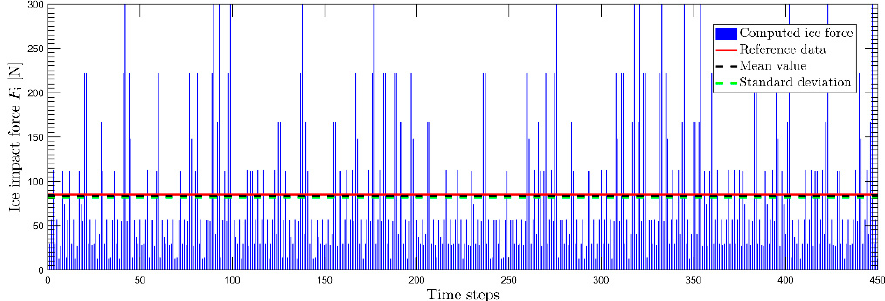
Figure 14. Result comparison for V = 0.41 m/s: ( a ) Case 1: Initial setup; ( b ) Case 1.1: Modified setup.